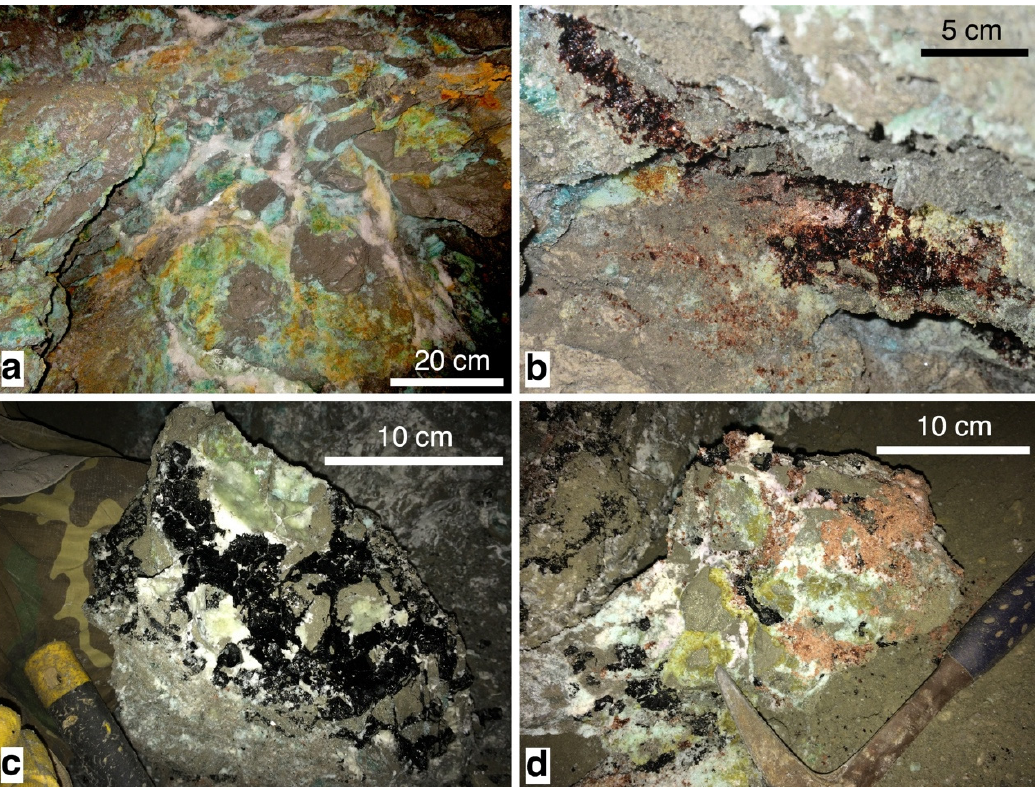
Figure 2. The sulfate occurrence of the Monte Arsiccio mine. ( a ) Melanterite (green-blue) with halotrichite + alunogen (white) and jarosite (yellow); ( b ) masses of well-crystallized römerite (brown); ( c ) boulder of pyrite ore (gold-gray) enclosing well-crystallized voltaite (black) and halotrichite (white and light green); ( d ) boulder of pyrite ore (gold-gray) encrusted with voltaite (black), halotrichite + alunogen + alum-(K) (white), and römerite (brown).